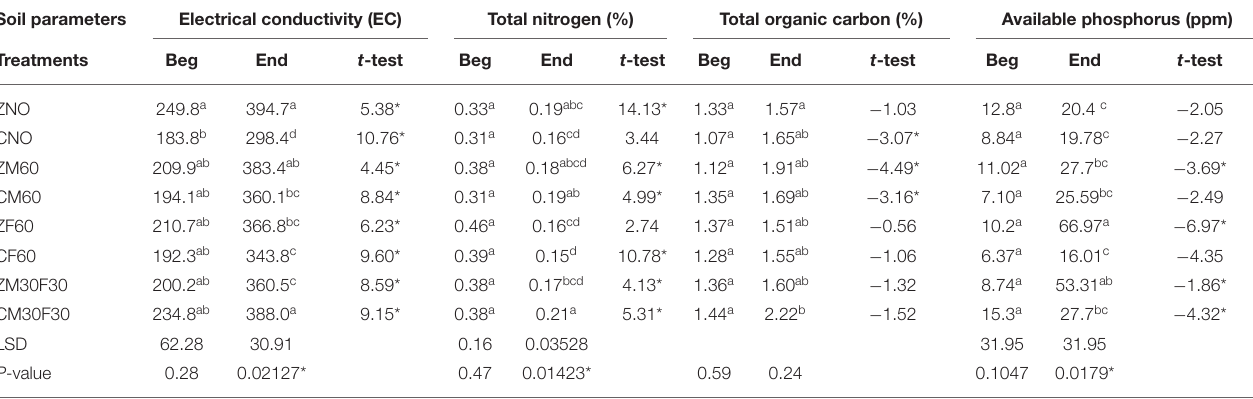
TABLE 3 | Soil chemical properties (0–15cm) at the beginning of short rains 2018 and end of long rain 2020 seasons at Kabati, Kitui County. Soil parameters Treatments